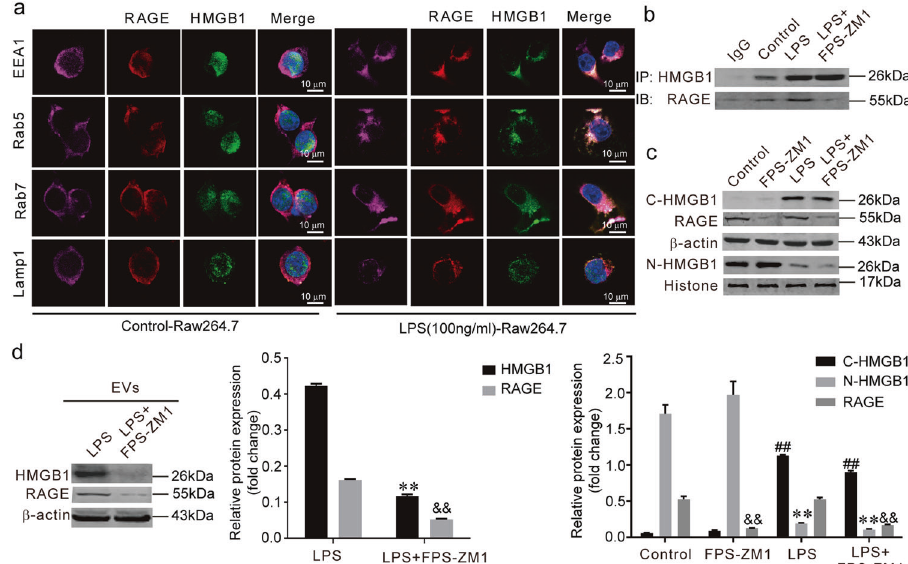
Fig. 3 HMGB1 absorbed into the EVs is depend on cytoplasmic RAGE. a The co-localization of cytoplasmic HMGB1, RAGE, endosome markers (EEA1, Rab5, Rab7) and lysosomal marker Lamp1. b The interaction between HMGB1 and RAGE was measured through Co-IP (co- immunoprecipitation). c The effect of FPS-ZM1 on the nucleocytoplasmic translocation of HMGB1. (**) P < 0.01 versus control group; ( && ) P < 0.01 versus control group; ( ## ) P < 0.01 versus control group. The protein levels were normalized to GAPDH and Histone 3.1. d The protein levels of HMGB1 an d RAGE within EVs. (**) P < 0.01 versus LPS group. ( && ) P < 0.01 versus LPS group. The results shown are representative of three independent experiments.